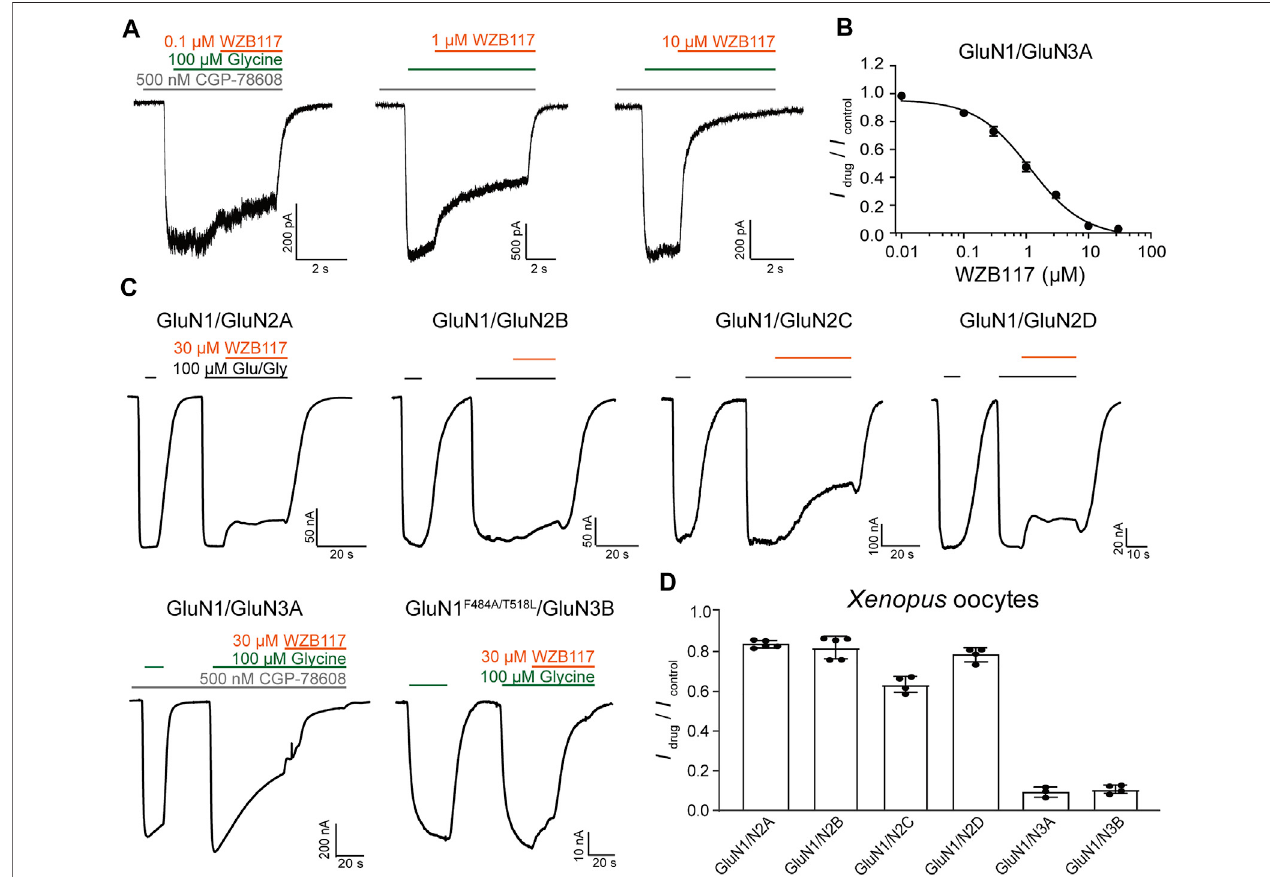
FIGURE 3 | Effects of WZB117 on GluN1/GluN3A receptors. (A) Representative traces of GluN1/GluN3A receptors with WZB117 application at the indicated concentrations. Whole-cell patch-clamp recording was performed on HEK-293 cells stably expressing GluN1/GluN3A receptors. (B) Dose-response curve of WZB117 on recombinant GluN1/GluN3A receptors (IC 50 = 1.15 ± 0.34 μ M, n = 6-7). (C) Representative traces of indicated receptors with WZB117 application. TEVC recording was performed on Xenopus oocyte expressing indicated receptors. Since currents were not observed for WT GluN1/GluN3B receptors, the mutant channel GluN1-4a F484A/T518L /GluN3B was used instead (Kvist et al., 2013). GluN1-1a was always used unless otherwise stated. (D) Inhibitory effects of WZB117 on various NMDAR subtypes in Xenopus oocytes.